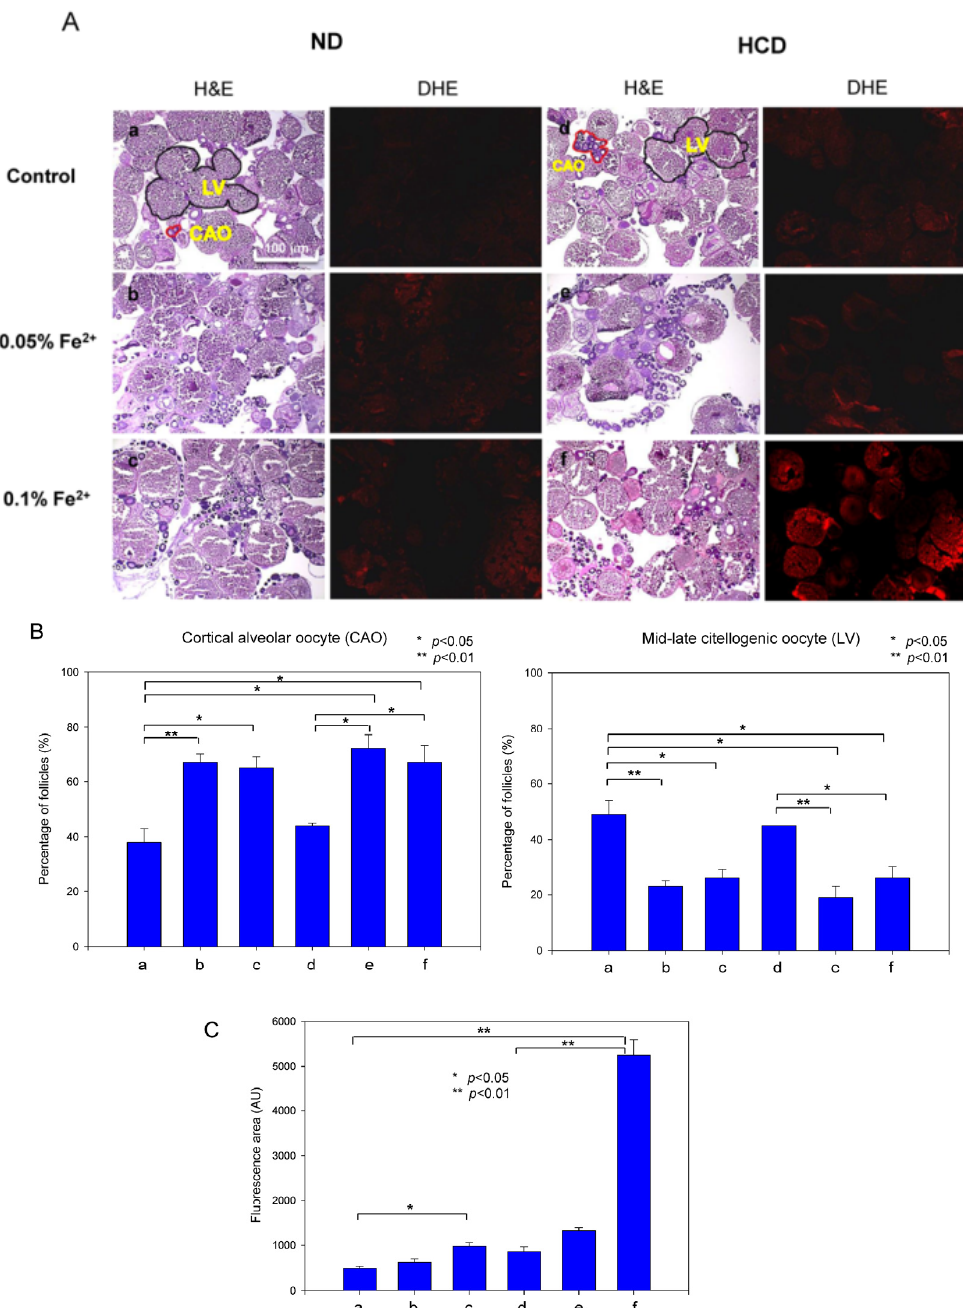
Figure 9. Histological analysis of ovarian tissue. ( A ) H & E staining of frozen ovarian tissues from zebrafish fed 0.05% and 0.1% Fe 2+ under normal diet (ND) or high cholesterol diet (HCD) for 24 weeks. CAO, cortical alveolar oocytes; LV, Mid-late vitellogenic oocytes (scale bar 100 µ m). Reactive oxygen species production at 48 hours post fertilization (hpf) as visualized by DHE staining using quantification of fluorescence (Ex = 588 nm, Em = 615 nm); ( B ) Graph shows the average value of CAO and LV area. a, ND control; b, ND + 0.05% Fe 2+ (wt/wt in diet); c, ND + 0.1% Fe 2+ (wt/wt in diet); d, HCD control; e, HCD + 0.05% Fe 2+ ; f, HCD + 0.1% Fe 2+ . *, p < 0.05; **, p < 0.01; ( C ) Quantification of DHE stained area by computer-assisted morphometry using Image Proplus software (version 4.5.1.22; Media Cybernetics, Rockville, MD, USA). *, p < 0.05; **, p < 0.01.